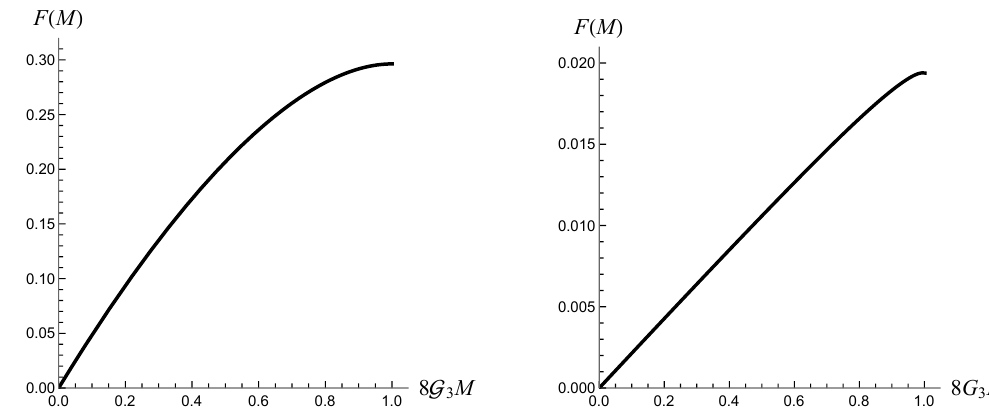
Figure 6 . Left : form factor F ( M ) computed holographically. When backreaction is present, the upper bound in the mass, set by the Nariai limit, is lower. Right : F ( M ) found from renormalized stress tensor of a single conformal scalar in conical dS 3 . For comparison, the holographic result must be multiplied by the central charge c (cid:29) 1